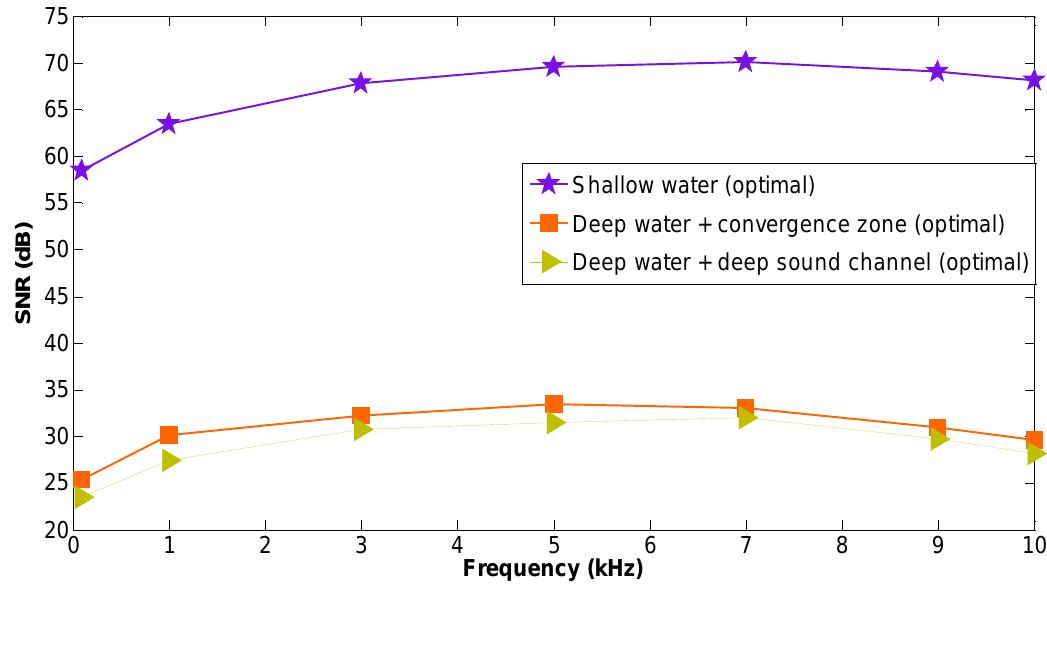
Figure 18. Average SNR as a function of frequency in shallow and deep